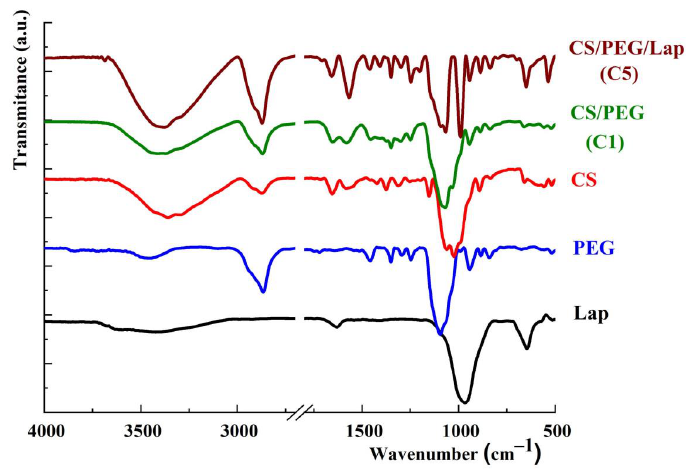
Figure 3. FTIR spectra of CS/PEG films with/without Lap and the pure components. In CS/PEG spectrum, the band corresponding to OH and NH stretching vibrations is shifted from 3350 cm −1 in CS spectrum to about 3400 cm −1 . Moreover, it was observed the shift of the peak corresponding to C – O – C group of chitosan from 910 – 1130 cm −1 to 980 – 1180 cm −1 . These changes suggest the formation of new intermolecular interactions be- tween CS and PEG by hydrogen bonds. The bands corresponding to amide I and amide II groups from CS are not shifted but the appearance of the peaks is changed and peaks increase in intensity. In addition, the peak attributed to C=O bending from – NHCO – groups is slightly shifted from 1654 cm −1 to 1649 cm −1 due to the additional interactions between CS segments and OH groups of PEG [58]. Comparing the spectra of CS/PEG film and Lap with that of CS/PEG/Lap film, some significant differences can be identified. CS/PEG/Lap spectrum shows the peaks corre- sponding to both CS/PEG film and Lap, but with a higher intensity due to the various interactions which are formed between the three components of the sample. The broad- band attributed to OH and NH vibrations at 3400 cm −1 in CS/PEG film is slightly shifted to a lower value of wavenumber, namely to around 3368 cm −1 . This shifting is due to hy- drogen bonds and electrostatic interactions between the amino and hydroxyl groups of CS with Si – OH and Mg – OH from the Lap structure [59,60]. Moreover, a significant in- crease in peak intensity is observed for N – H stretching vibration from – NH 2 groups at 1568 cm −1 as a result of the additional hydrogen bonds between clay particles and CS chains [61]. The stretching vibration of Si – O and Mg – O bands at 966 cm −1 and 646 cm −1 in the Lap spectrum are shifted to 991 cm −1 and 650 cm −1 , respectively, in CS/PEG/Lap film spectrum. Moreover, the stretching vibration of the C – O – C group at 1026 cm −1 in the CS spectrum is shifted to 1068 cm −1 in CS/PEG/Lap film spectrum. These results indicate the formation of hydrogen bonding between the three components. The morphological and texture analysis of the films surface was performed by SEM and POM. Figure 4 shows the SEM images for CS/PEG films with and without Lap.